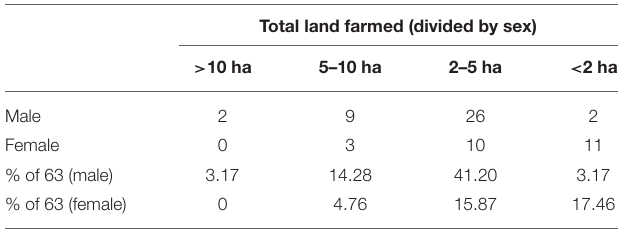
TABLE 2 | Distribution of land farmed by size and